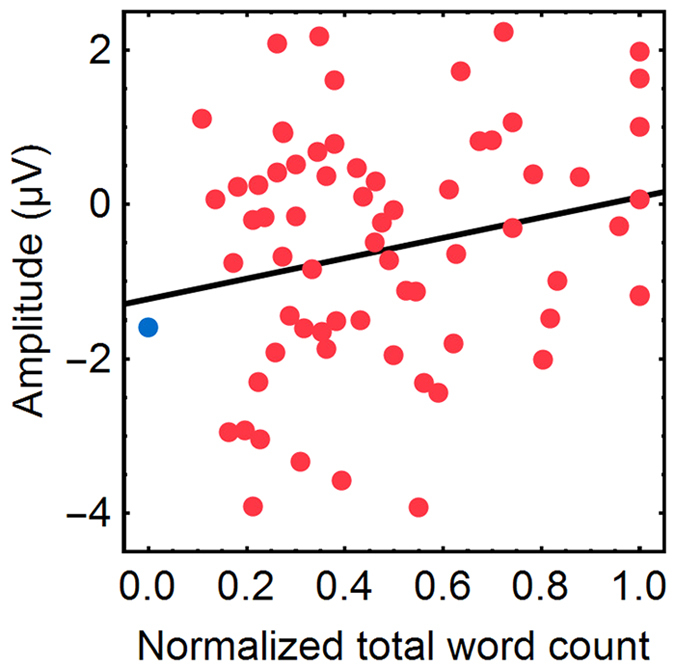
Correlation between the length of the conscious experience and the amplitude of the TMS-evoked response for all participants.The red dots represent the signal amplitude of the TMS-evoked response and the normalized total word count of individual awakenings. The line shows a linear fit to the data with r = 0.21 and P = 0.039. The blue circle represents the average amplitude of the data associated with no conscious experience.